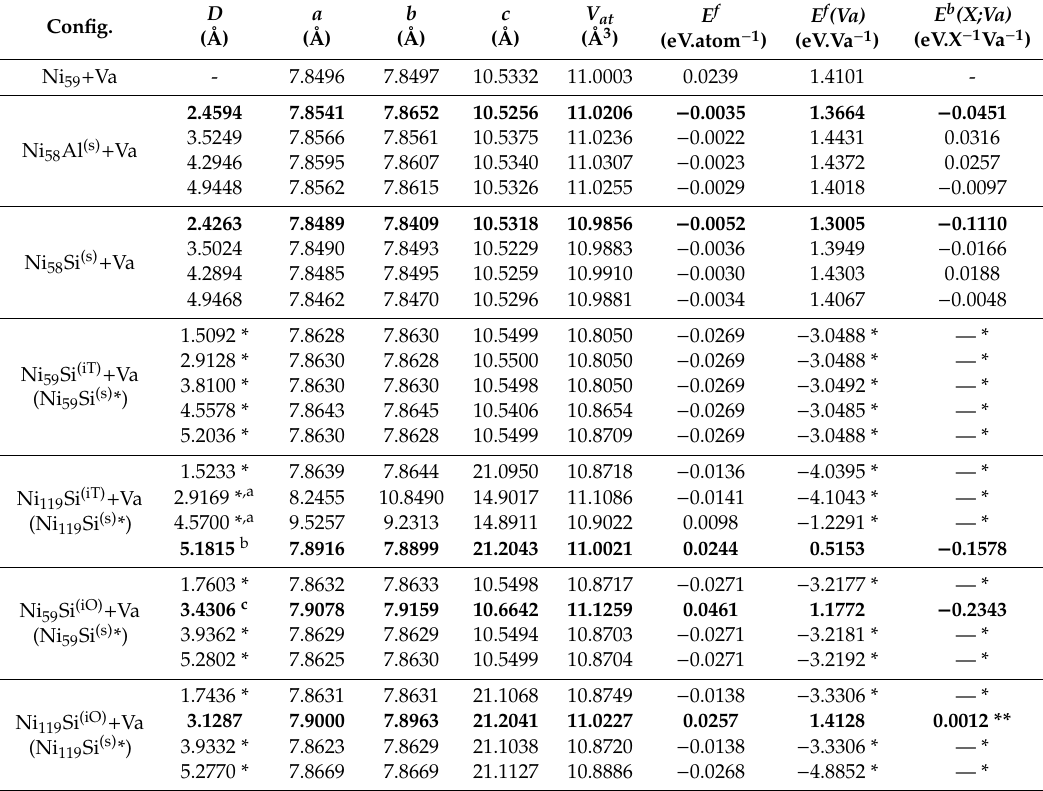
* The structure in parentheses denotes the final equilibrium arrangement after the relaxation and the D values correspond to the distances before relaxation. E f corresponds to the energy of formation of Ni 59 Si (s) or Ni 119 Si (s) . In this case, E f (Va) is the energy di ff erence between structures with interstitial and substitutional Si and E b (X;Va) cannot be evaluated as Va disappeared during the structure relaxation. ** In case of the structure Ni 119 Si (iO) + Va, the value of E b (X;Va) was calculated with respect to structures Ni 59 + Va and Ni 120 Si (iO) . Hence, the value − 0.2343 eV.X − 1 Va − 1 should be considered more reliable as it was calculated using the energies of structures with comparable size. a The shape of the cell has changed and the equilibrium angles are not α = β = γ = 90.00 ◦ . b The value of D